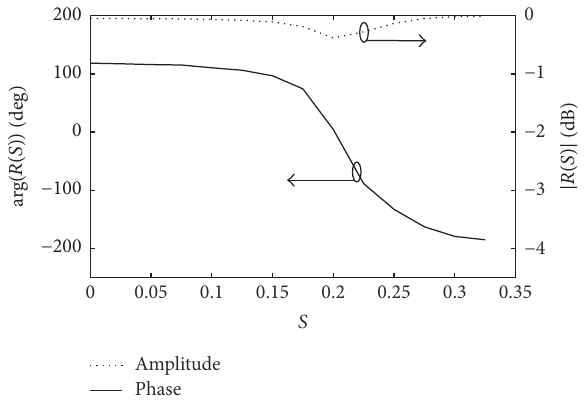
Figure 15: Simulated reflection coefficient versus 𝑆 ( 𝐿 = 7.6 mm, Δ𝑥 × Δ𝑦 = 0.3𝜆